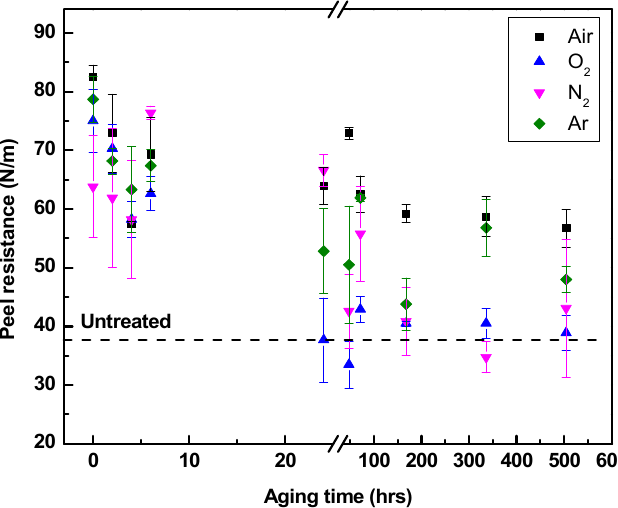
Figure 8. Peel resistance values of treated PU samples with air, O 2 , N 2 , and Ar vs. aging time.